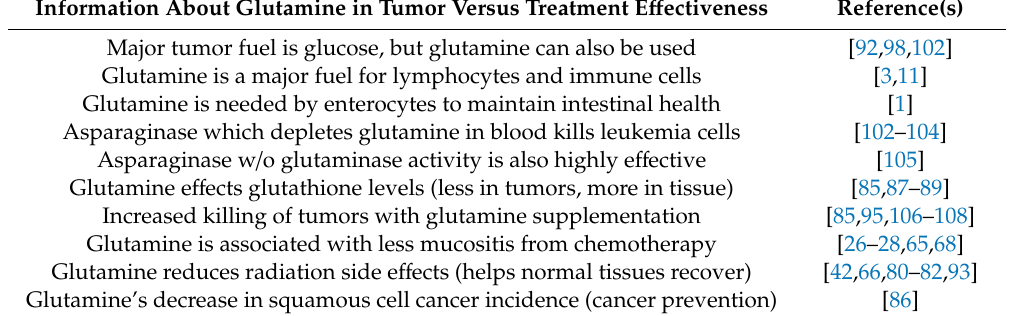
Table 2. Physiologic balancing act by glutamine. Damage Control + Tissue Regeneration and Tumor